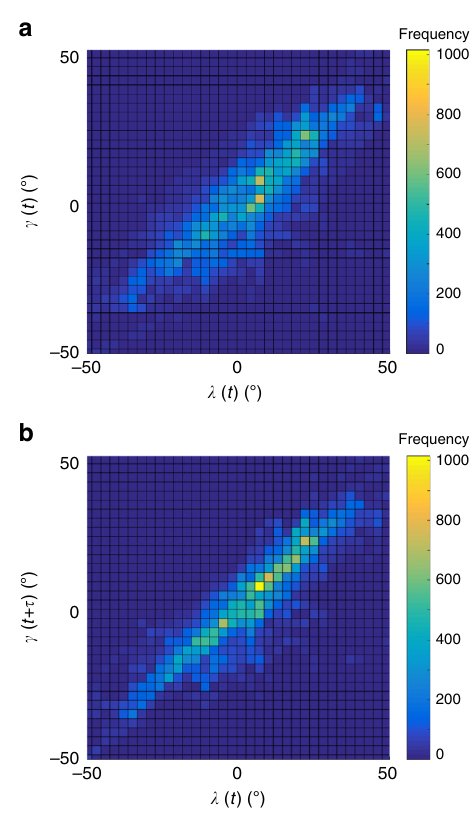
Fig. 3 Correlation of track angle and line-of-sight angle. Each fi gure panel plots a two-dimensional histogram of track angle γ against line-of-sight angle λ for all sample points over all fl ights: a no delay between γ ( t ) and λ ( t ); b track angle γ lagged by τ = 0.16 s delay, representing the median value of the delay at which the correlation between γ ( t + τ ) and λ ( t ) was maximised for each fl ight. The linear association in b indicates that the attack trajectories of the hawks approximated a delayed